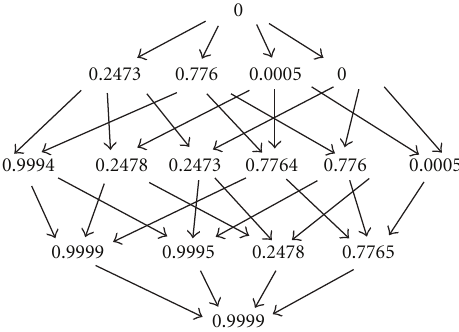
Figure 2: Lattice of fuzzy measure values of the constituent singleton sets [39] of rule 1 for Box and Jenkins’s